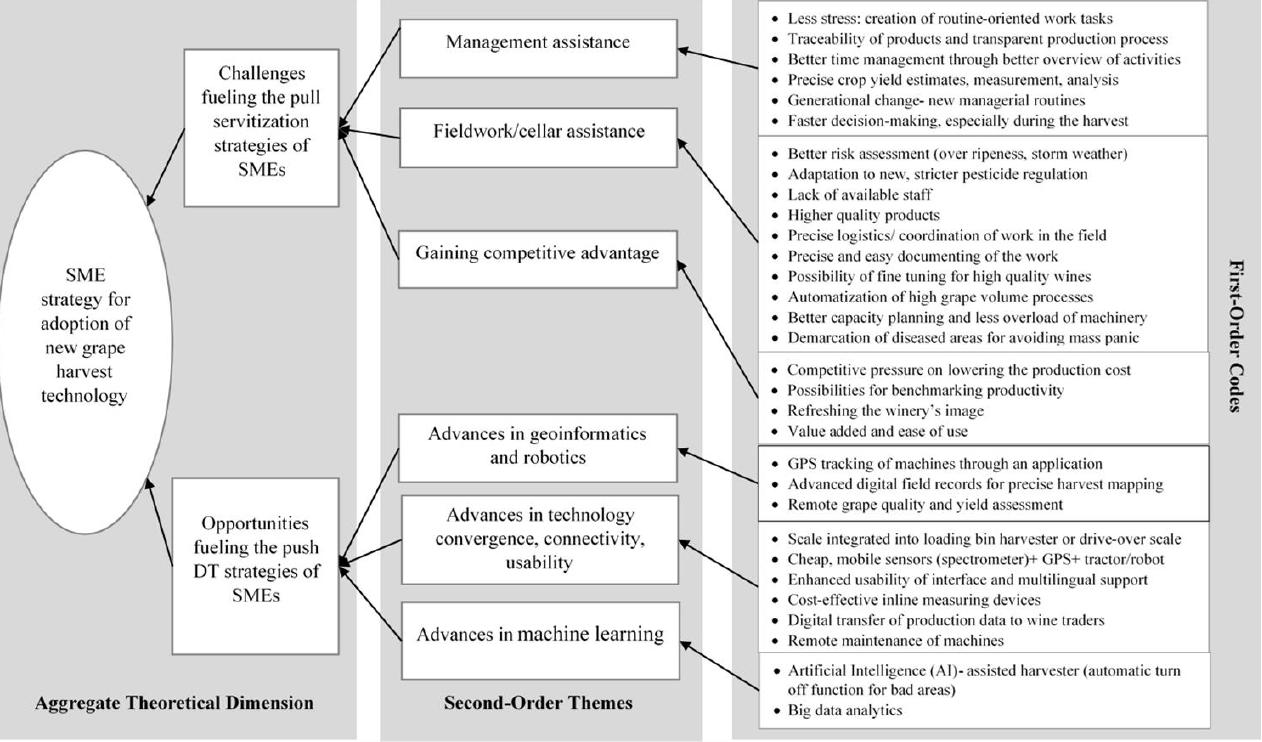
Figure 2. Adoption of grape harvest innovation- challenges acting as pull factors and new technologies acting as push factors.